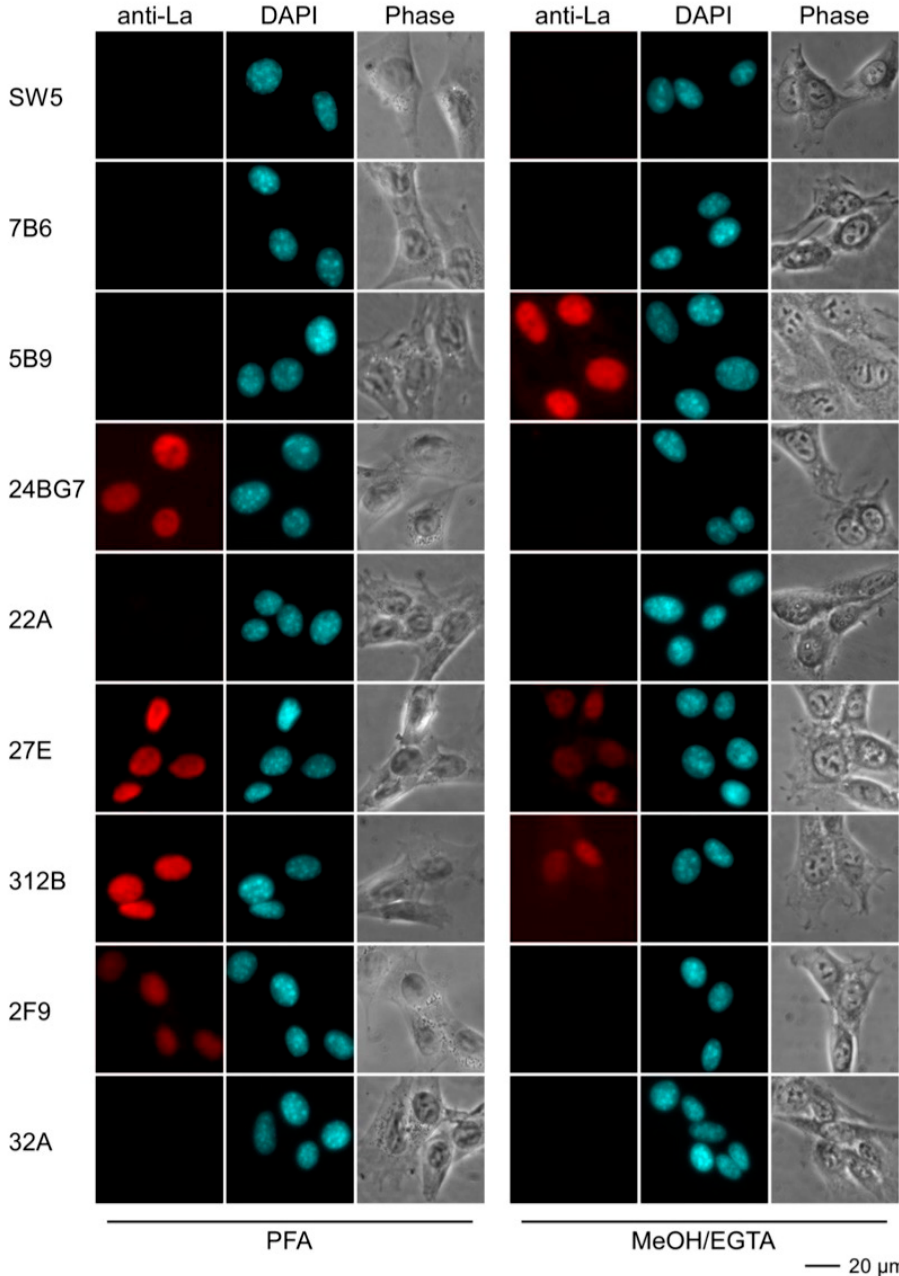
Figure 9. Epifluorescence microscopy of mouse 3T3 cells stained with anti-La mabs. Prior to the staining, cells were fixed with either paraformaldehyde (PFA) or methanol (MeOH)/EGTA. For detection of the primary anti-La mabs, we used an anti-mouse-IgG conjugated with Alexa Fluor ® 568 as secondary ab. DNA was stained with DAPI. Phase, phase contrast image.